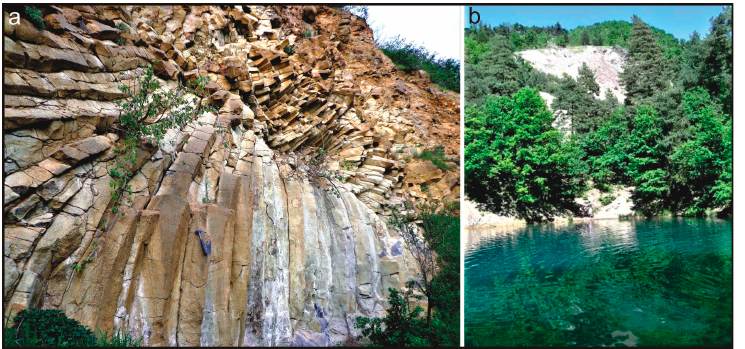
Figure 22. Nature monuments in the Gut â i Mountains ( a ) “Stone Rosette”, an assemblage of radially- disposed, columnar-jointed andesite lava in a subaqueous emplaced extrusive dome (Photo: Marinel Kovacs); ( b ) Blue Lake, an anthropic, mining-related lake in the Mine Hill (Mons Medius) at Baia Sprie town (Photo credit: Ioan